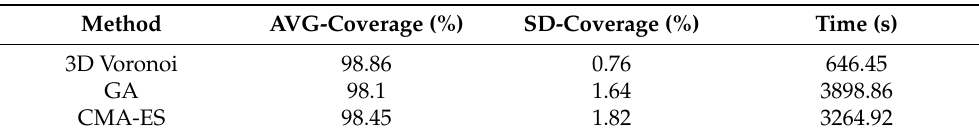
Table 1. Results of 3D Voronoi, GA, and CMA-ES algorithms including coverage average (AVG- coverage) and its standard deviation (SD-coverage).